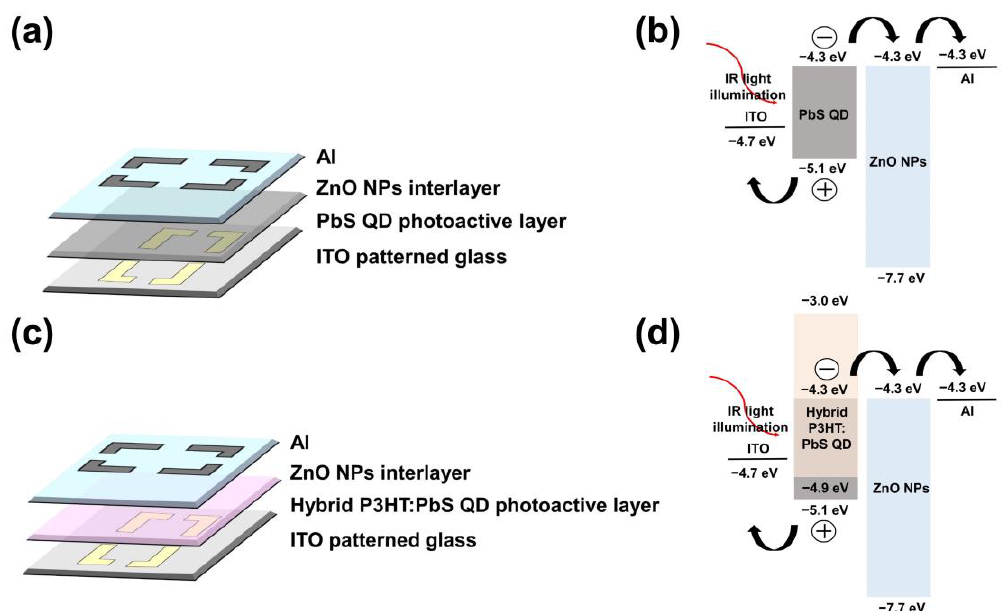
Figure 3. Schematic diagram of fabricated devices: ( a ) The structure of the PbS QD-based device, ( b ) the bandgap of the P3HT:PbS QD-based device, ( c ) the structure of the hybrid P3HT:PbS QD-based device and ( d ) the bandgap of the hybrid P3HT:PbS QD-based device.